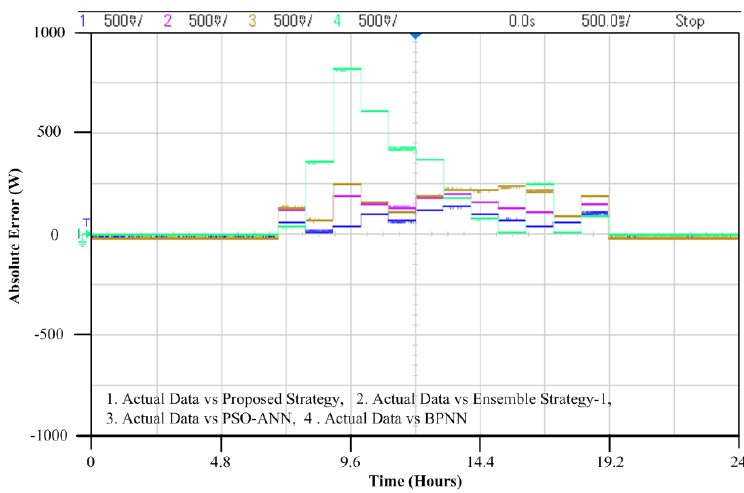
Figure 10. Absolute error of all strategies for PV power